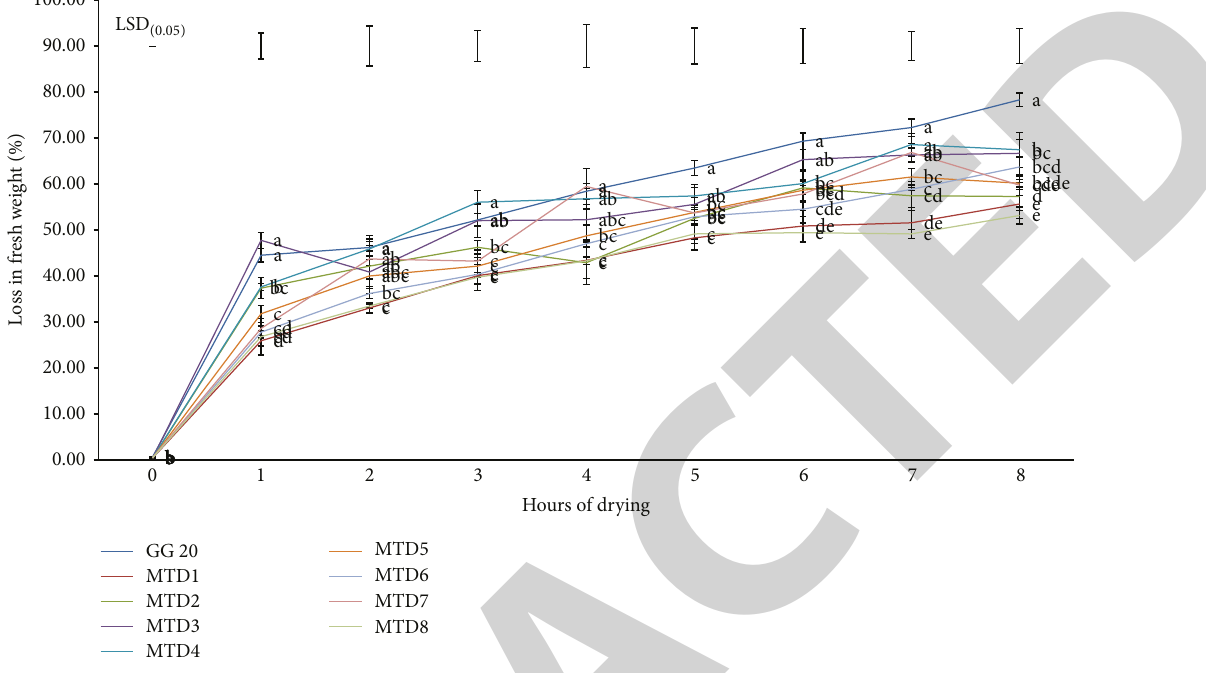
Figure 5: Excised-leaves water loss assay shows significantly higher water loss in WT whereas reduced water-loss was found in mtlD transgenics. Data are average ± SE from three independent experiments; bars on the top represent the LSD 0.05 . Bars having same lower-case letters within treatments are not significantly different ( 𝑃 ≤ 0.05 ).